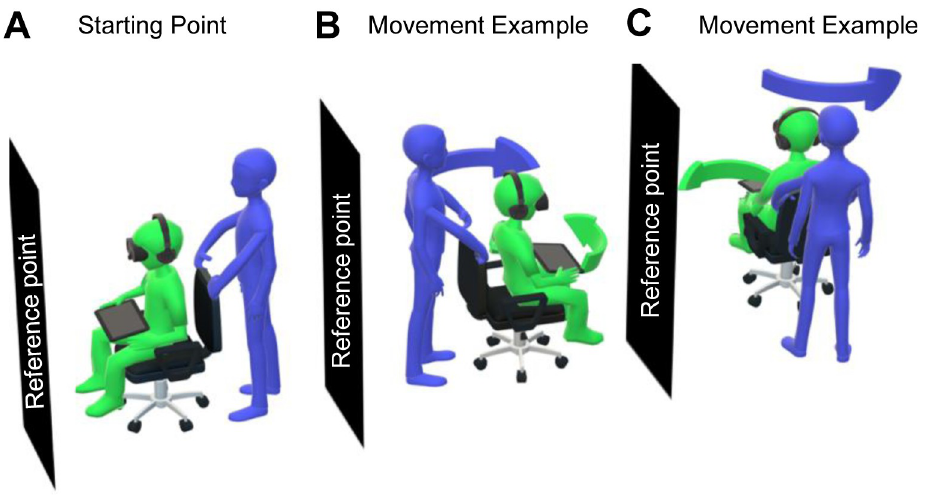
Fig 1. Semantic representation of the vestibular rotation